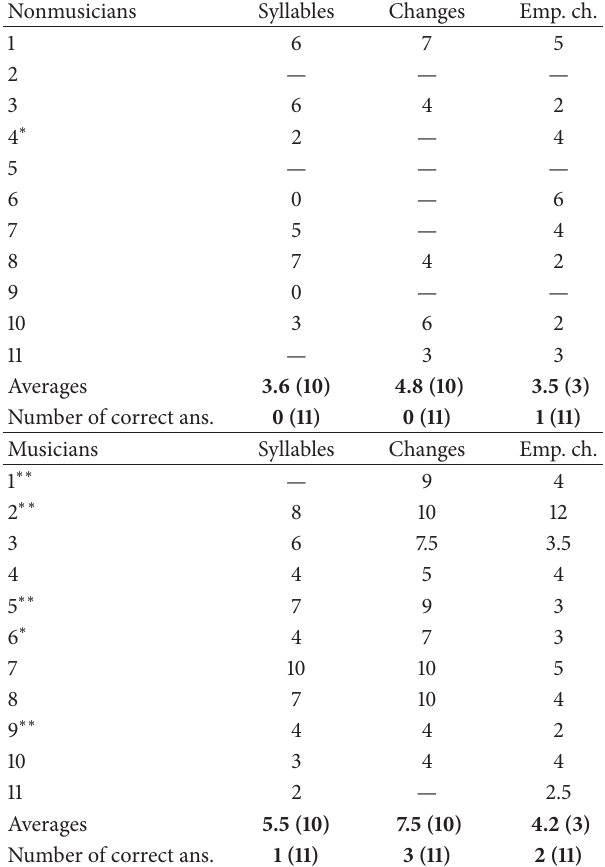
Table 7: Table of the number of syllables of harmonic changes, the number of chord changes, and the number of employed chords recorded by nonmusician and musician subjects. The subjects with the asterisk are those completely successful in the harmonization task, while the subjects with the double asterisk are those partially successful in the harmonization task.